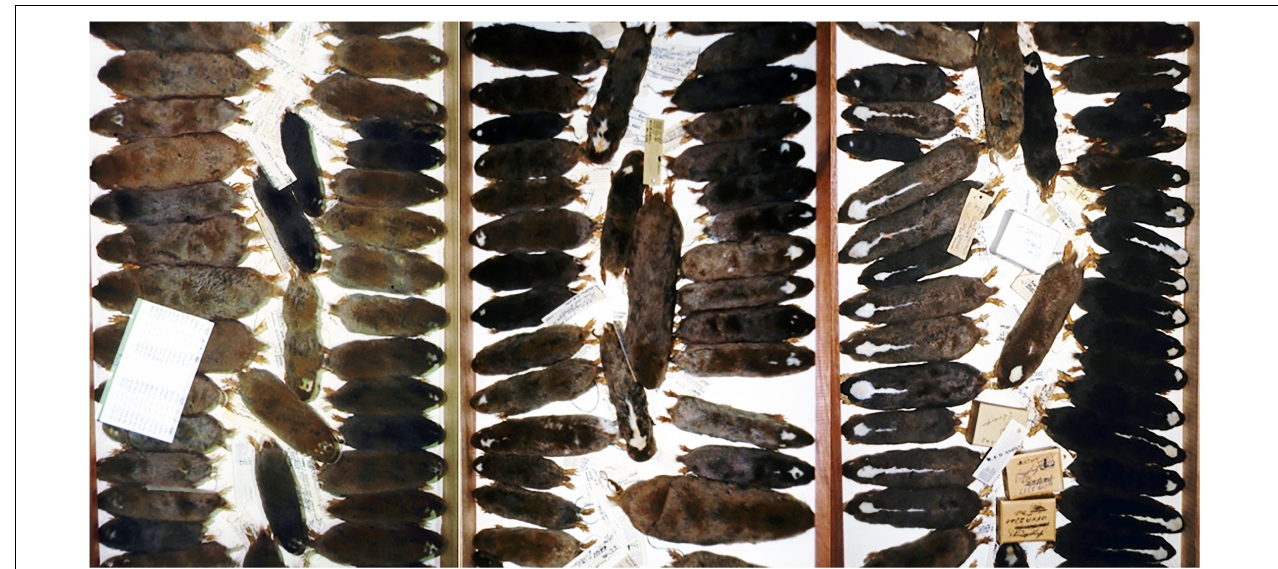
FIGURE 1 | Stuffed specimens of Fukomys mole-rats showing the variability in the size of the headspot (bles) in the collections of the Natural History Museum of Zimbabwe in Bulawayo. (Left) Mole-rats (incl. F. mechowii ) from Northern Zambia, (Right) mole-rats (incl. F. damarensis ) from Southern Africa.